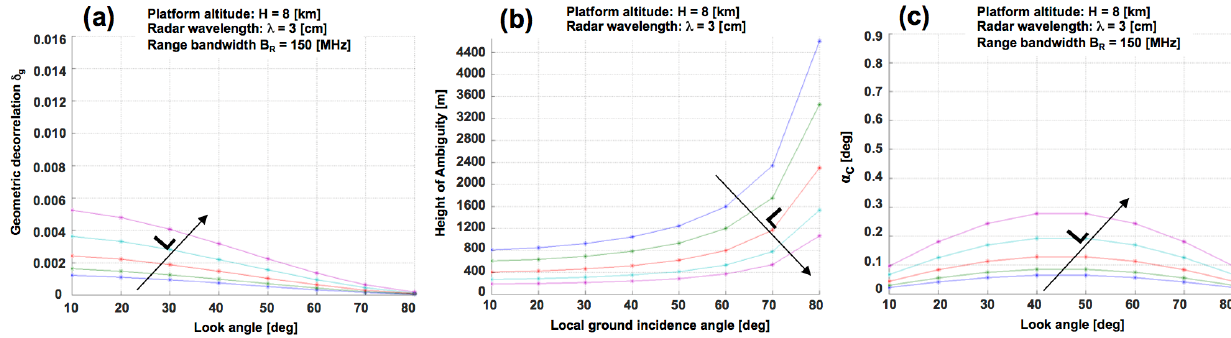
Figure 11. ( a ) Height of ambiguity h a , ( b ) geometric decorrelation  geo , and ( c ) critical angle α C vs. look angle for B = 150 MHz,  = 3 cm , platform altitude H = 8 km, vertical baseline L = [0.3, 0.4, 0.6, 0.9, 1.3] m (from blue to purple), baseline orientation angle  = 90° (vertical orientation see Figure